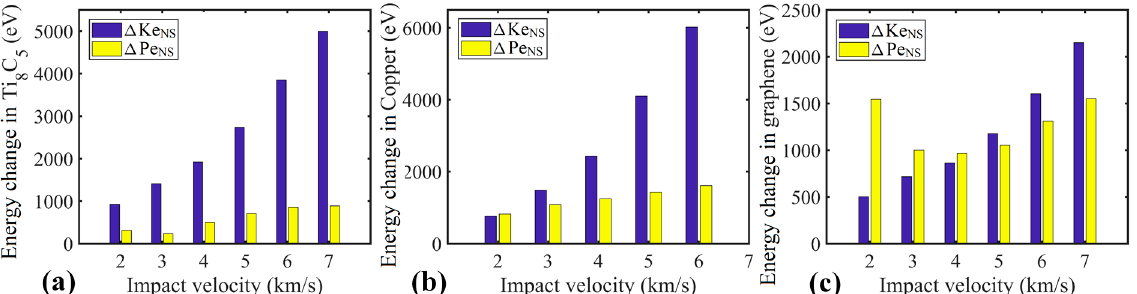
Figure 9. Energy breakdown for various nanosheets at the moment of perforation. Figures ( a – c ) represent the kinetic energy gain ( ∆ Ke NS ) and the potential energy gain ( ∆ Pe NS ) for Ti 8 C 5 , copper and the graphene nanosheet, respectively.